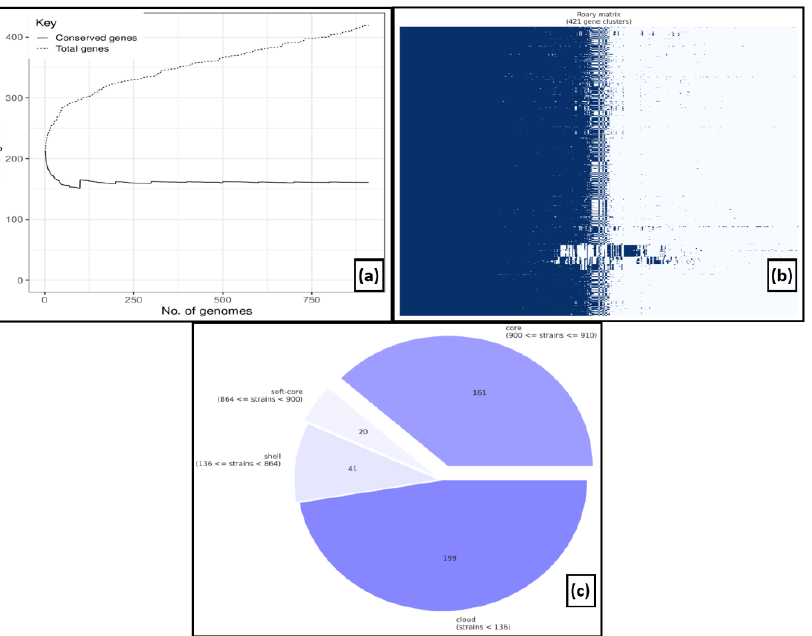
Figure 1. Pan-genome analysis ( a ) The number of conserved genes vs. total genes, ( b ) gene clusters, ( c ) pie-chart representing a number of core genes, soft-genes, shell, and cloud genes.